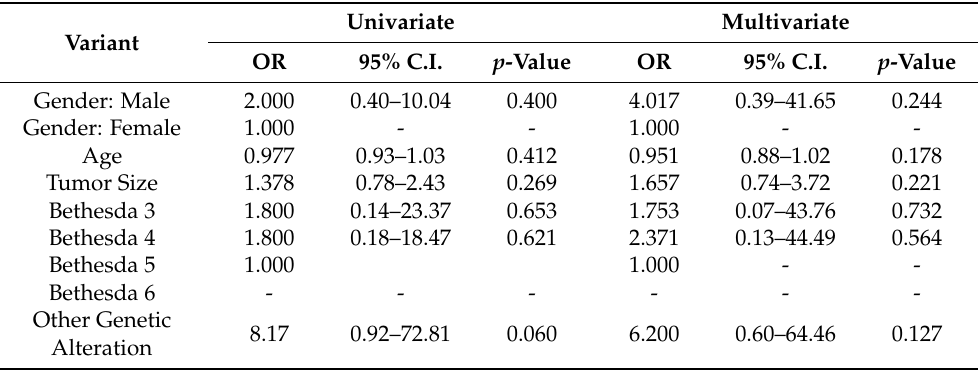
Table 5. Logistic regression results to predict the chance of aggressive tumors using clinicopathologi- cal characteristics in the 47 patients with thyroid cancer.